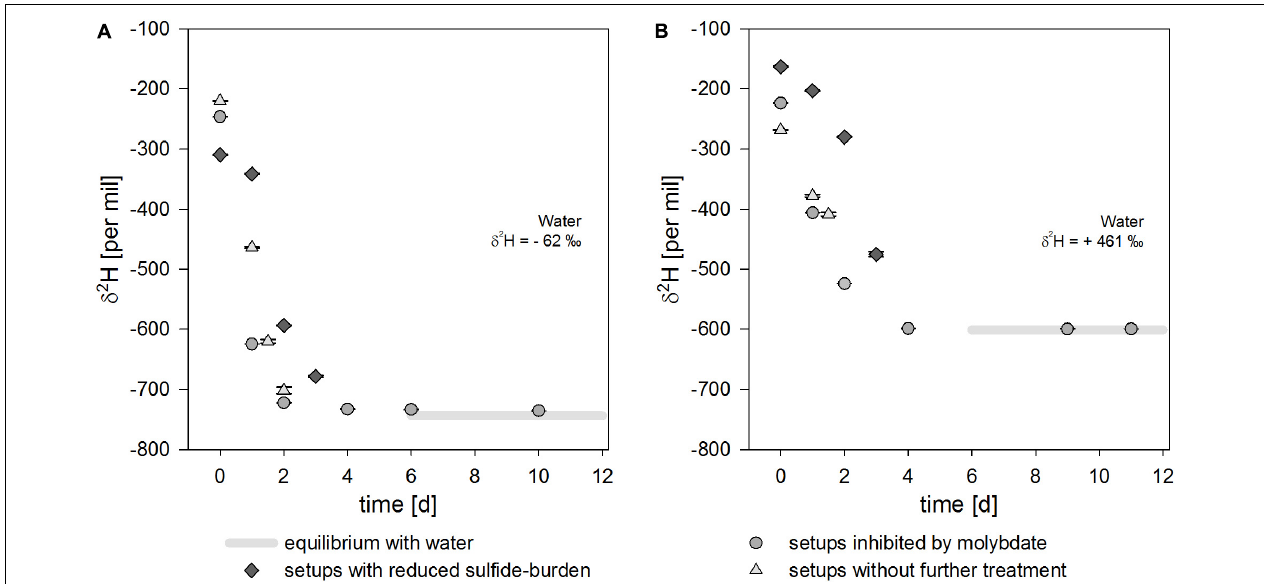
FIGURE 3 | Isotope signal over time for three experimental setups in either water with δ 2 H 2 O = –62 reached after about 6 days and indicated by light gray bars. The uncertainty of 2 σ is shown and often smaller than the symbol.